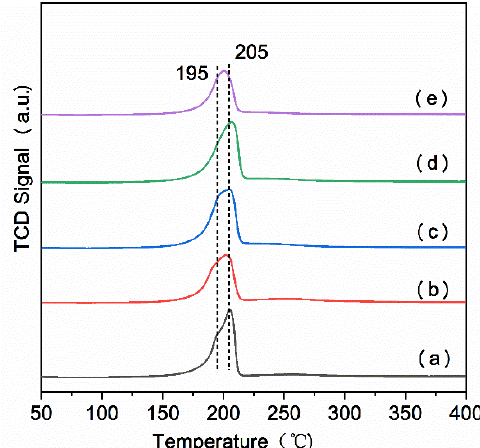
Figure 4. H 2 TPR profiles of the calcined xE-Cu – SiO 2 catalysts. (a) Cu/SiO 2 , (b) 0.04E-Cu/SiO 2 , (c) 0.08E-Cu/SiO 2 , (d) 0.12E-Cu/SiO 2 , (e) 0.3E-Cu/SiO 2 .